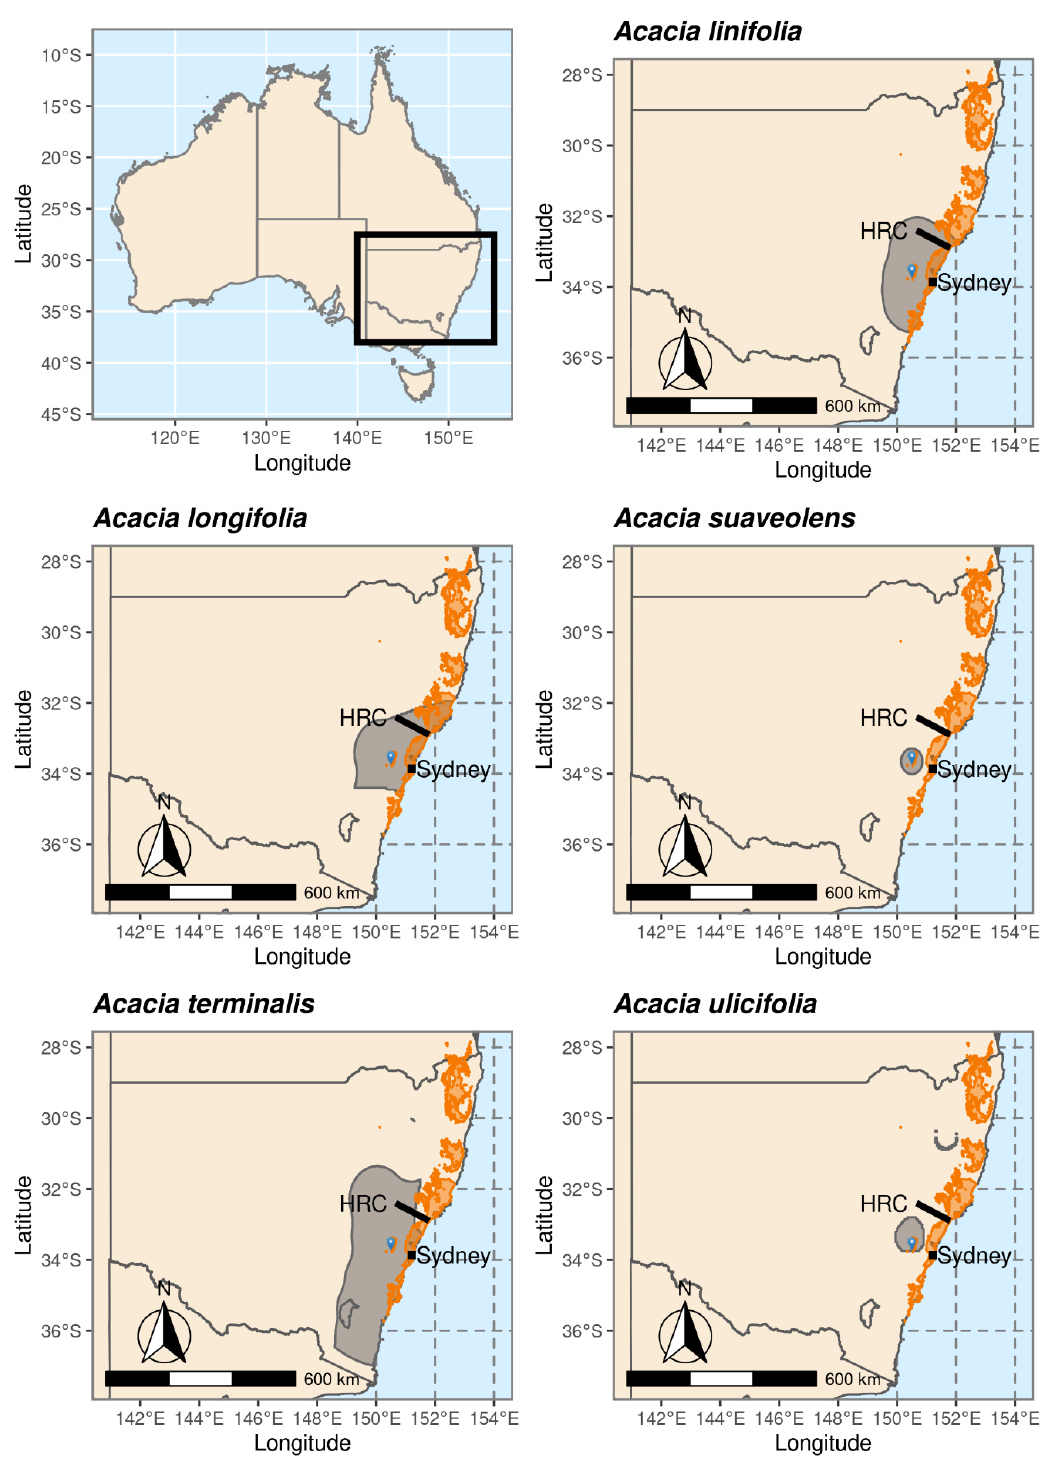
Figure 4. Empirically defined provenance boundaries generated using generalized dissimilarity models (GDMs) based on distribution-wide genomic datasets. All GDMs were evaluated at a common test location (blue teardrop; 33.65° S 150.5° E). GDM-derived provenance is shaded grey. Shaded orange are regions with climate that currently matches predicted 2070 climate at the test location. Matching future climate was assessed under a moderate change scenario (RCP4.5). The location of a major biogeographic barrier, the Hunter River Corridor (HRC), is also included.